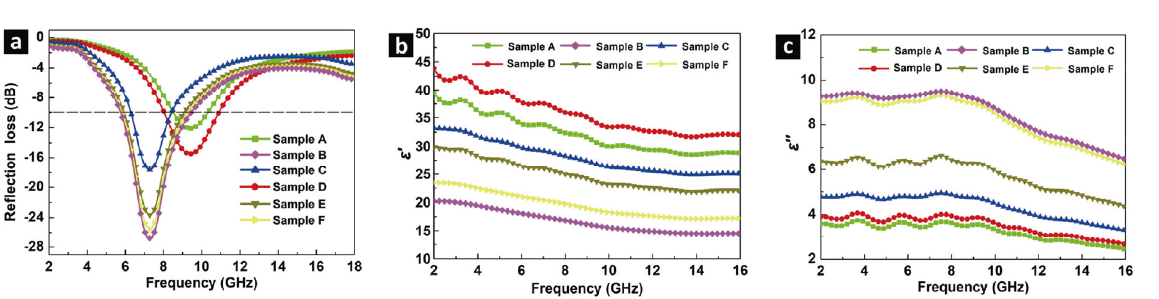
Fig. 7 (a) RL curves of the selected CoSe 2 microstructure composites at a thickness of 2 mm. (b, c) Relative complex permittivity of the samples: (b) real and (c) imaginary parts.